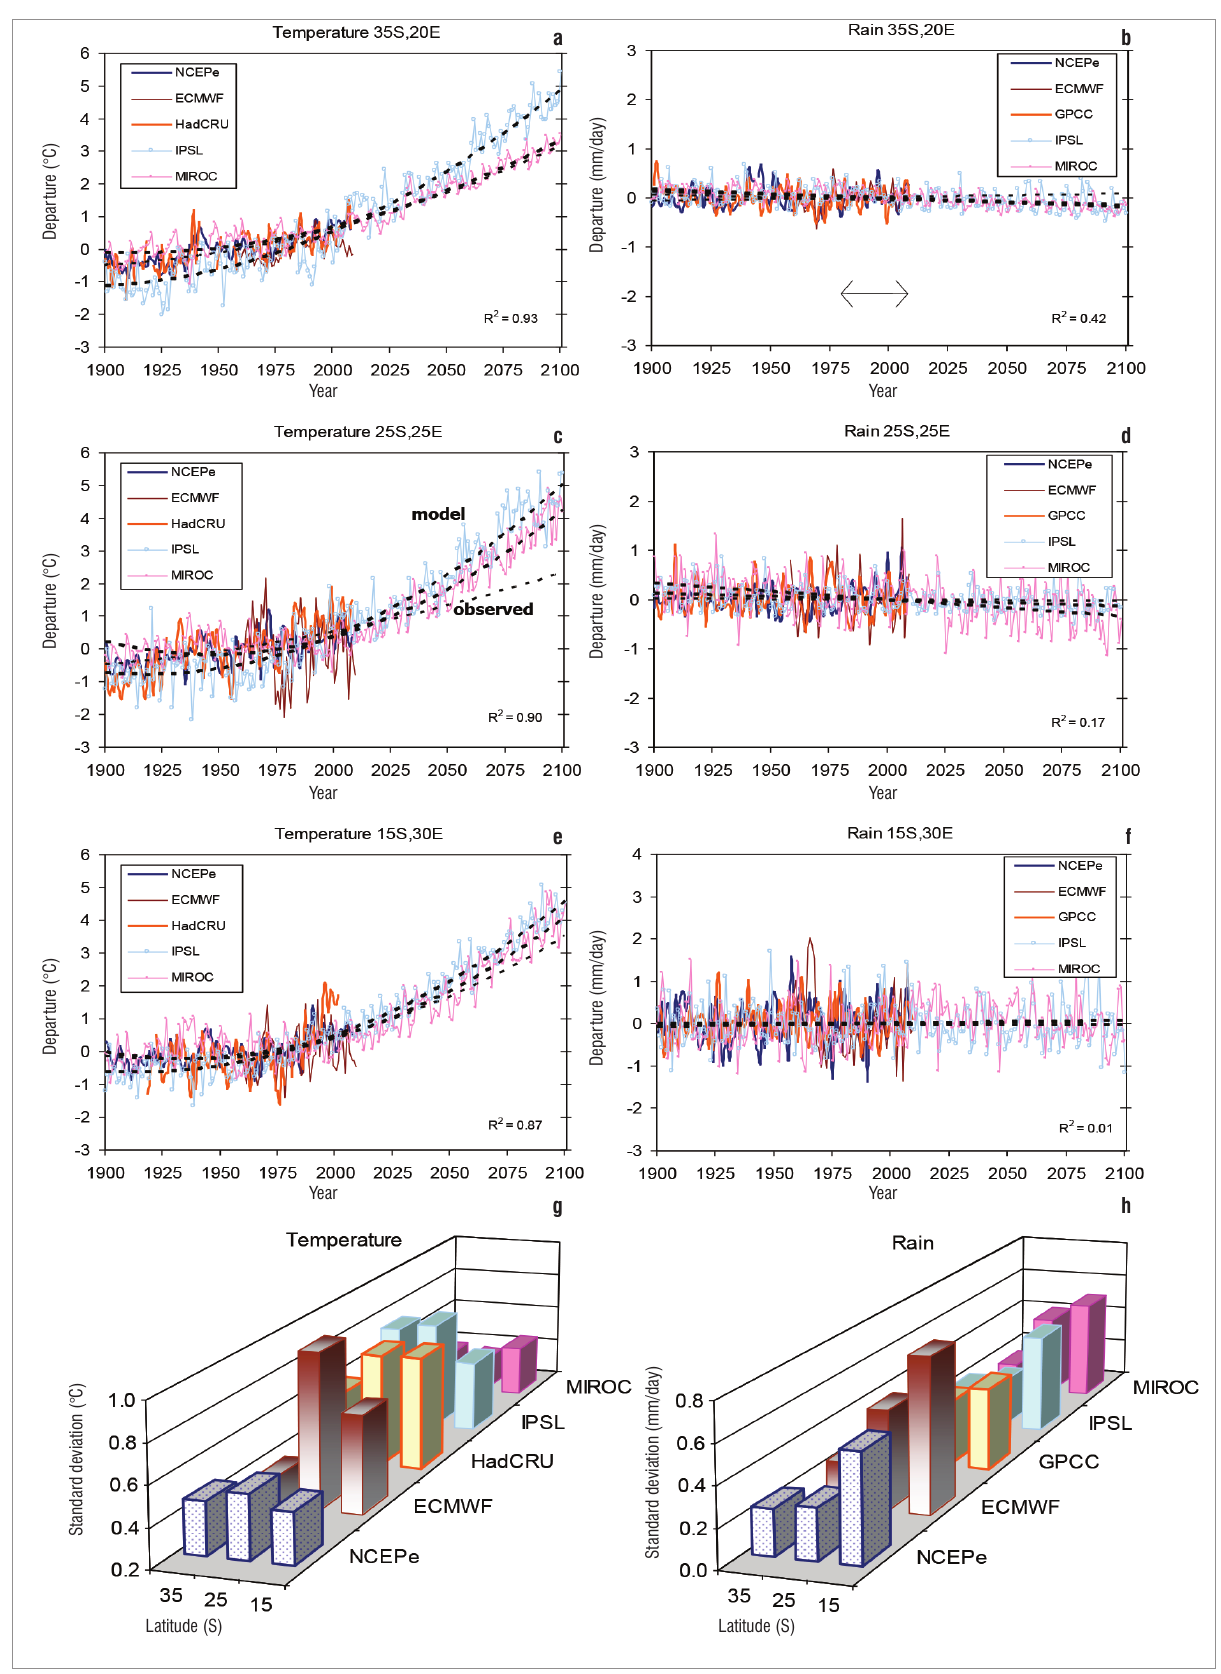
Figure 5: Temporal analysis of surface temperature (a,c,e) and rainfall (b,d,f) in three areas in southern Africa (rows) for observed and projected periods. Standard deviations for each series per latitude in the 20th century are given for (g) temperature and (h) rainfall. Period of analysis for Table 1 is shown in